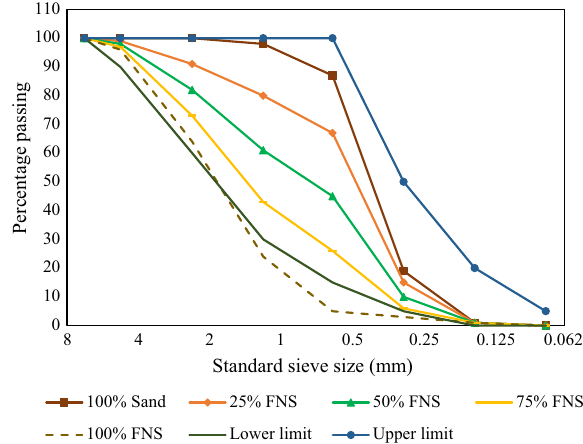
Fig. 3 Gradation of fine aggregates combining FNS and natural